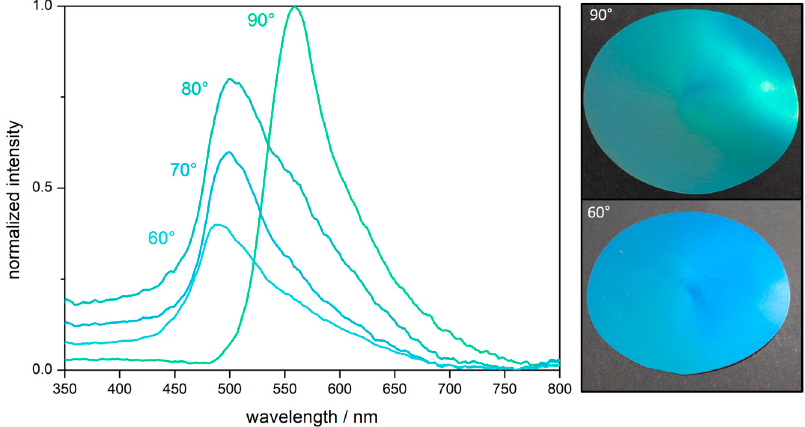
Figure 5. Angle-dependent UV/Vis reflection spectra of the opal film prepared from PS@P(NFHMA- co -TFEA- co - n BuA) core/interlayer/shell particles and corresponding photographs of the opal film at an angle of view of 90° and 60°. The final opal discs featured a diameter of 8